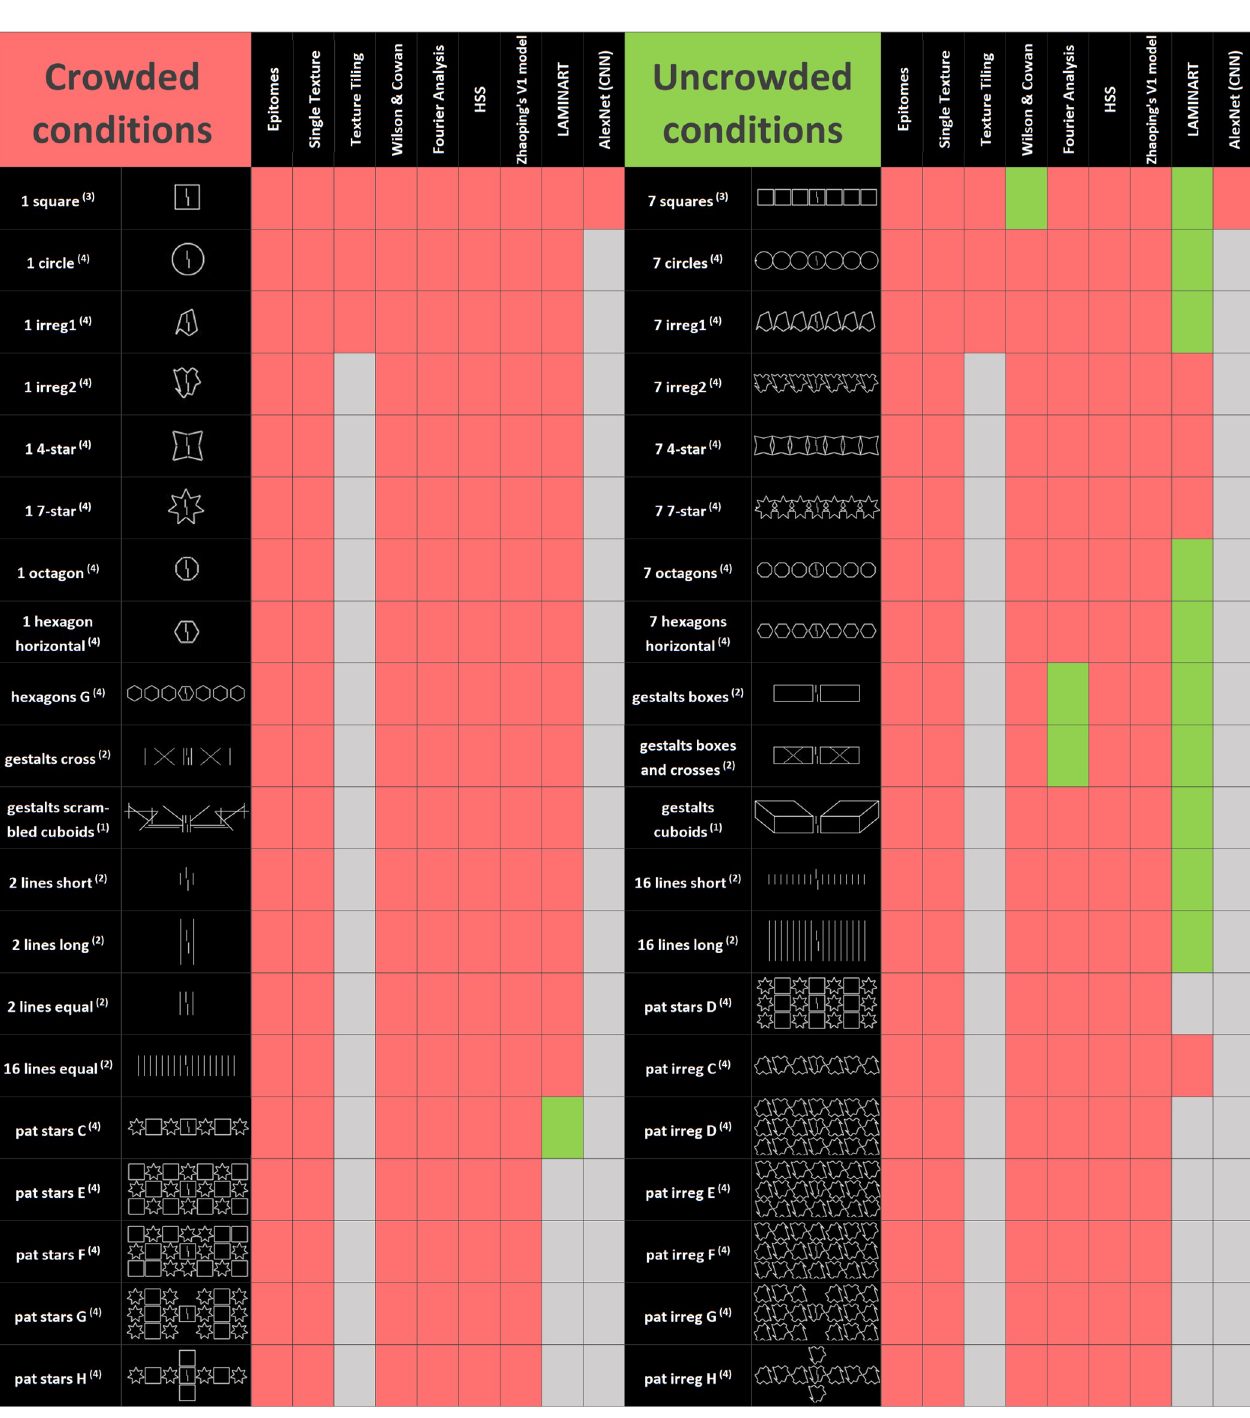
PLOS Computational Biology | https://doi.org/10.1371/journal.pcbi.1006580 May 10,